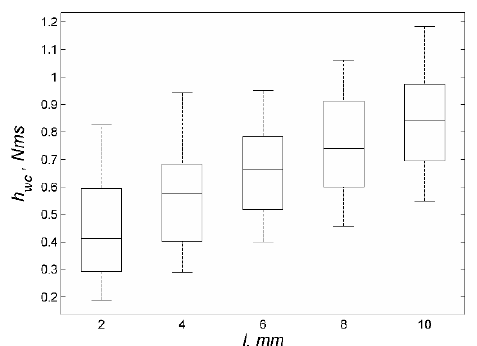
Figure 12. Box diagram of eccentricity of thrusters vector and angular momentum of reaction wheels.